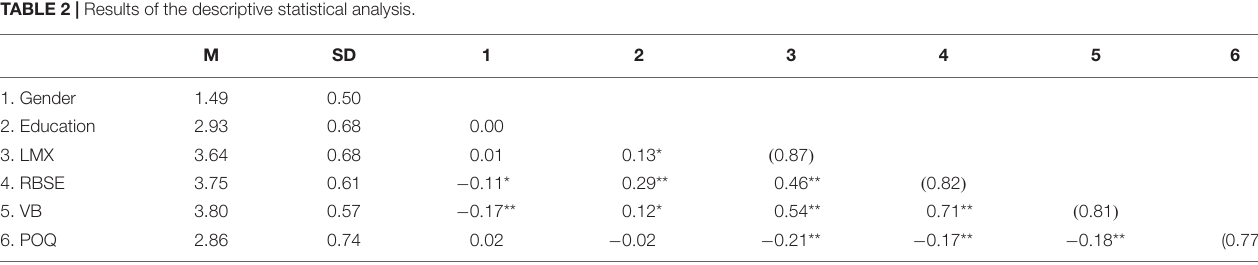
TABLE 2 | Results of the descriptive statistical analysis.